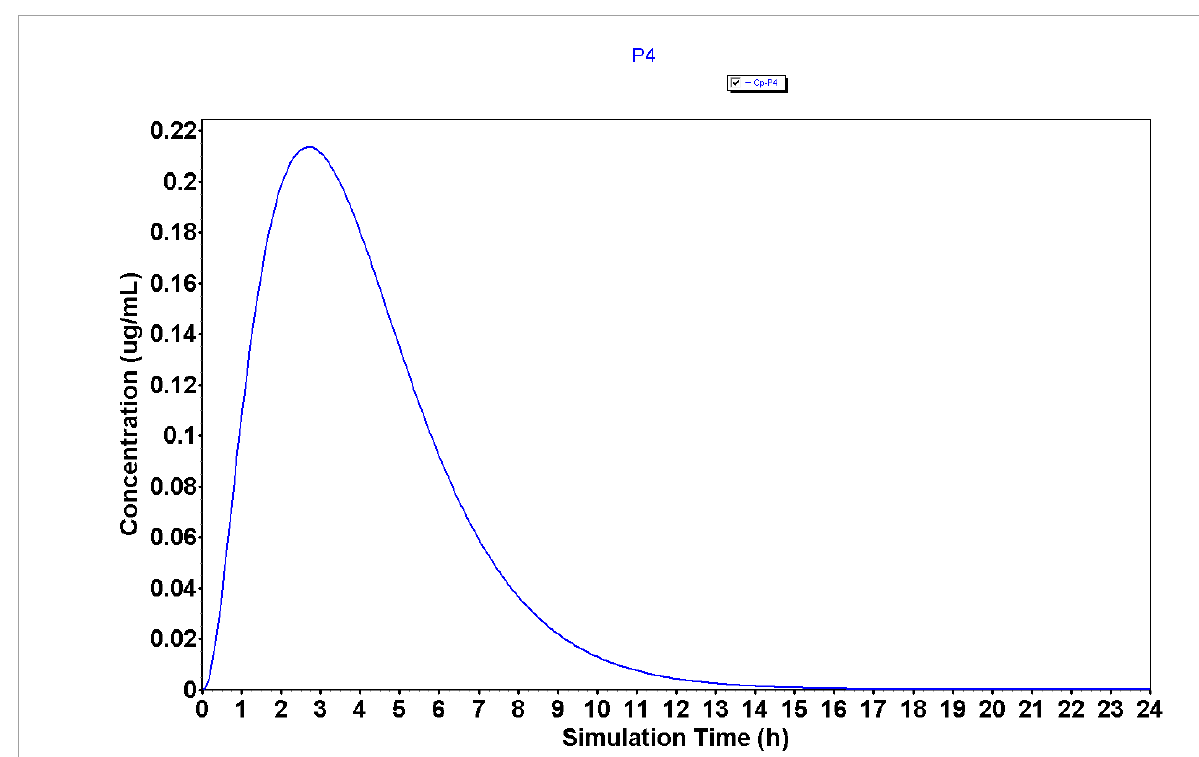
Figure 6. Plasma concentration of P4 generated using the GastroPlus ® software.